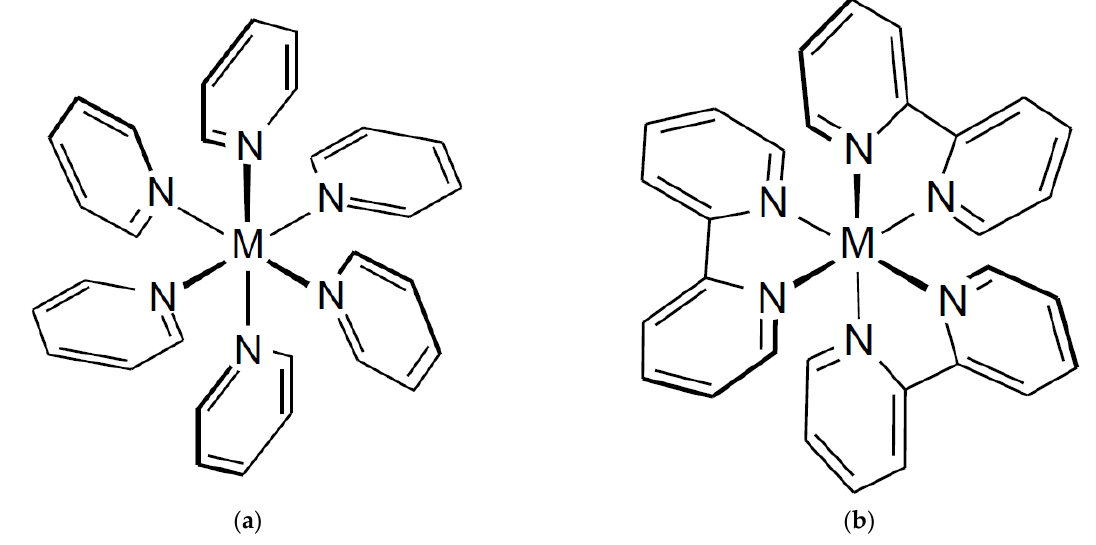
Figure 1. Chemical structures of pyridine and bipyridine complexes: ( a ) T h symmetric [M(py) 6 ] com- plex; ( b ) D 3 symmetric [M(bpy) 3 ] complex.